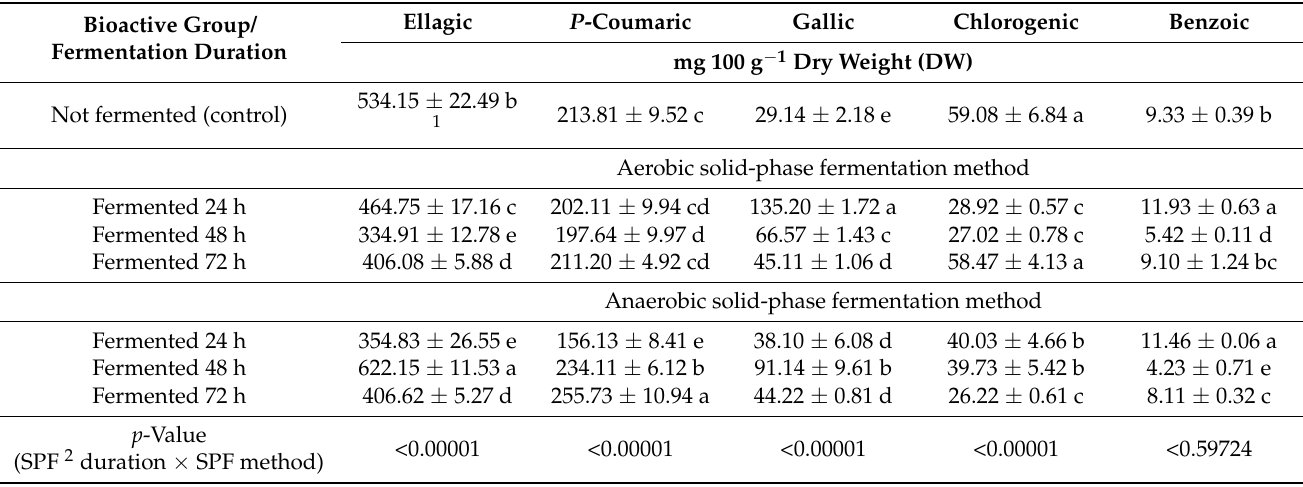
Table 2. The influence of solid-phase fermentation on the contents of individual phenolic acids in fireweed